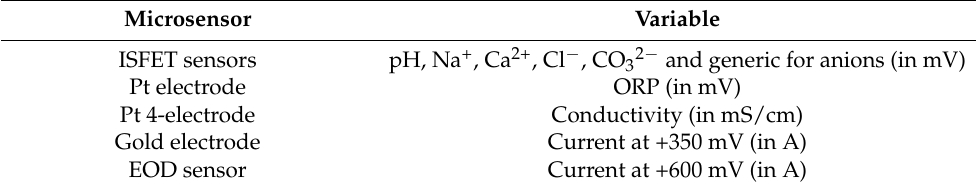
Table 4. Microsensors and variables used for constructing the multivariate